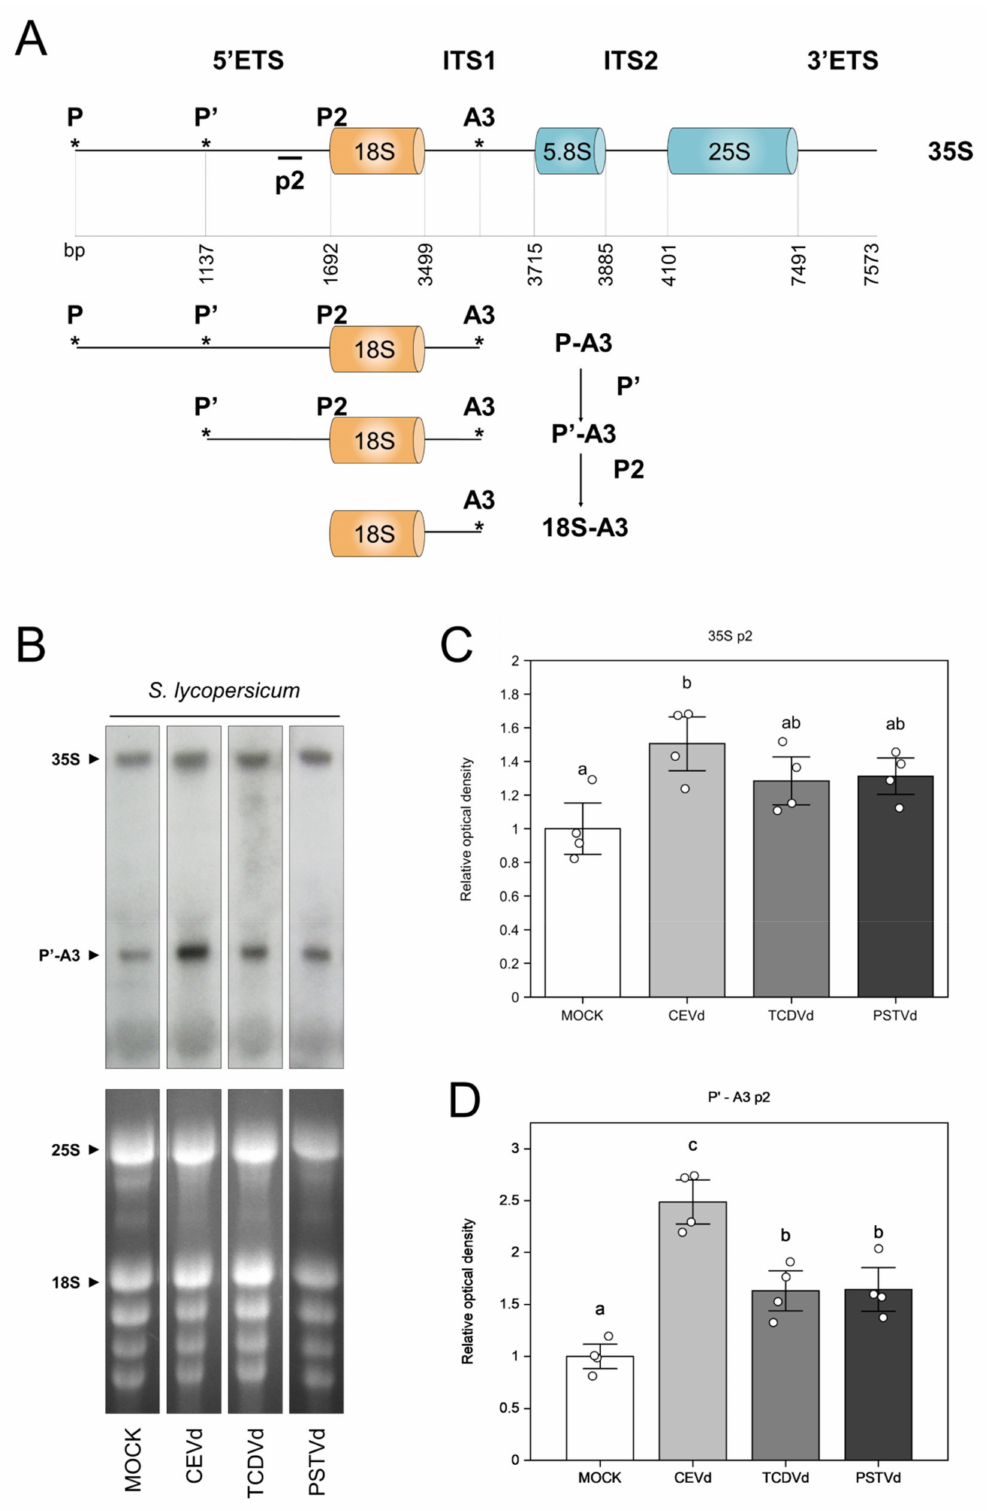
Figure 6. Alterations in S. lycopersicum rRNA processing upon agro-inoculation with CEVd, TCDVd, and PSTVd. ( A ) Pri- mary transcript and major 35S pre-ribosomal rRNA processing. Successive cleavages in A3, P’, and P2 and the corresponding P-A3, P’-A3, and 18S-A3 bands are indicated. ( B ) S. lycopersicum RNAs were extracted from agro-inoculated mock and infected leaves and hybridized for the detection of pre-rRNA 35S and P’-A3 with the p2 probe. Bottom image corresponds to EtBr-stained gel, and top image corresponds to Northern hybridization. Optical density quantification of the 35S band ( C ) and P’-A3 band ( D ). Data correspond to the mean ± SE of 4 biological replicates and their individual values (white dots). Data were analyzed using a Mann–Whitney test and different letters indicate significant differences ( p ≤